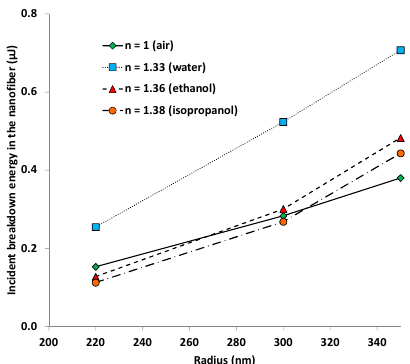
Fig. 2. LIB energy measurements for three nanofiber radii and four external